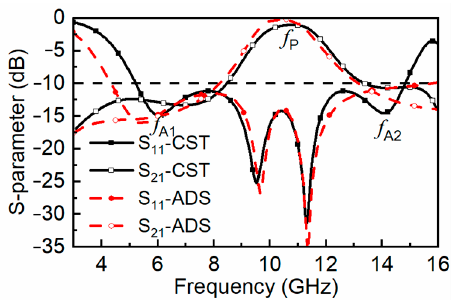
Figure 4. S -parameter and absorptivity of the proposed under normal incidence.